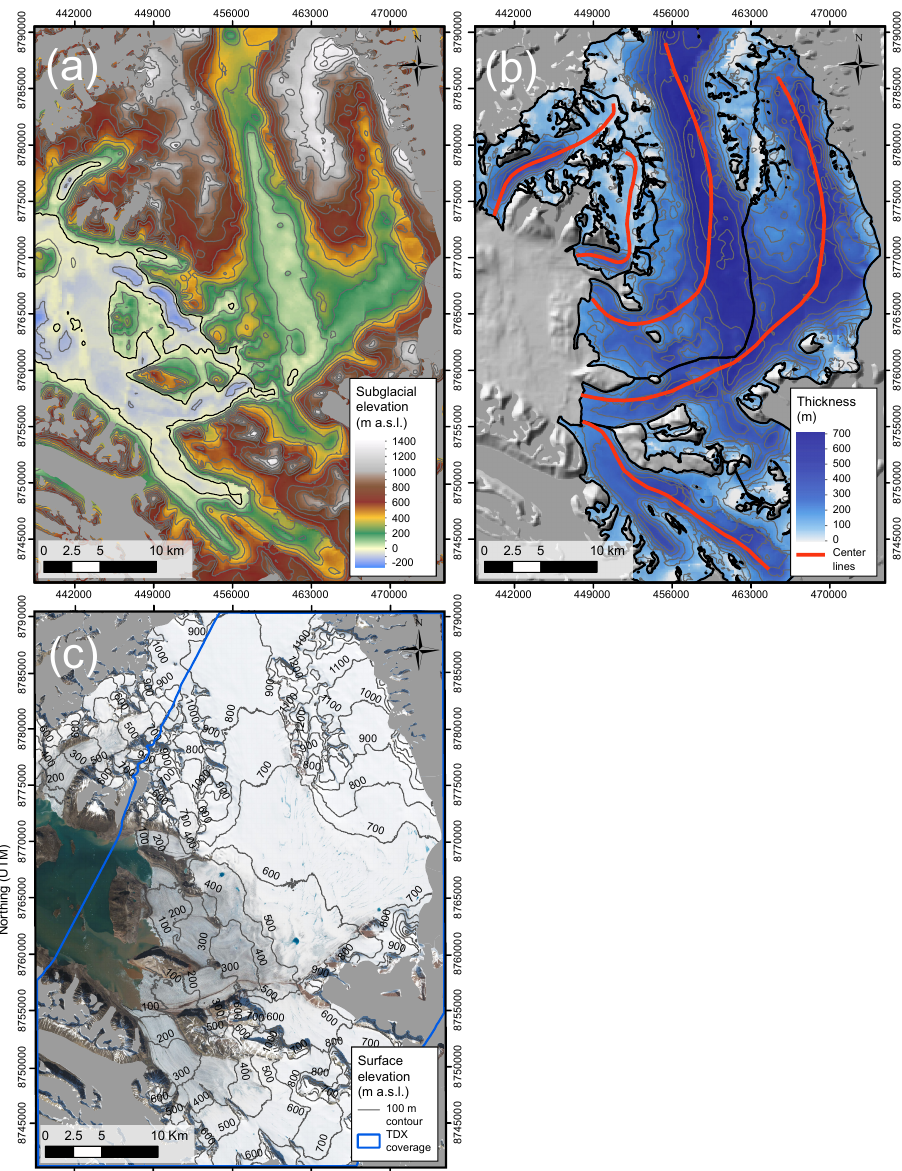
Figure 5. (a) Subglacial, bathymetric, and land elevation with 100m elevation contours (grey lines). (b) Ice thickness in 2014 with 100m elevation contours (grey lines) and glacier surface elevation catchments (black polygons). Hillshade image in the background from Fig. 5a. Statistics for each glacier are specified in Table 1. (c) Surface elevation in 100m contours showing the extent of the TANDEM-X (TDX) DEM (blue polygon). Background image is Sentinel-2 satellite image taken on 10 July 2016 (Copernicus, 2016). Grey areas in all figures are glaciers not covered in the study. Grid projection is Universal Transverse Mercator Zone